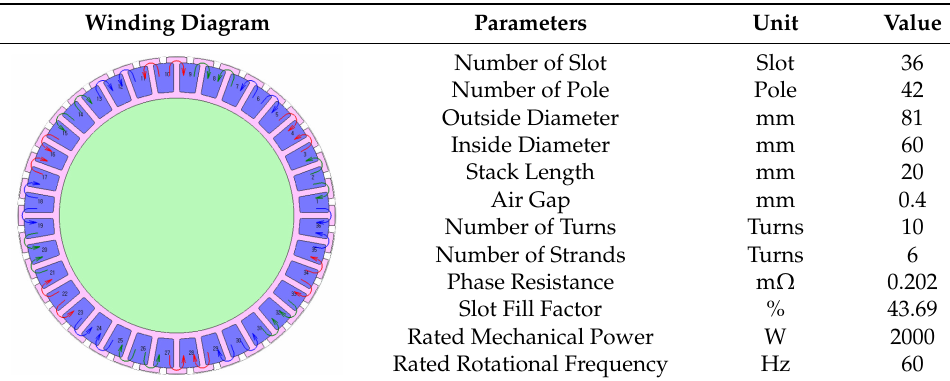
Table 1. Parameters of the